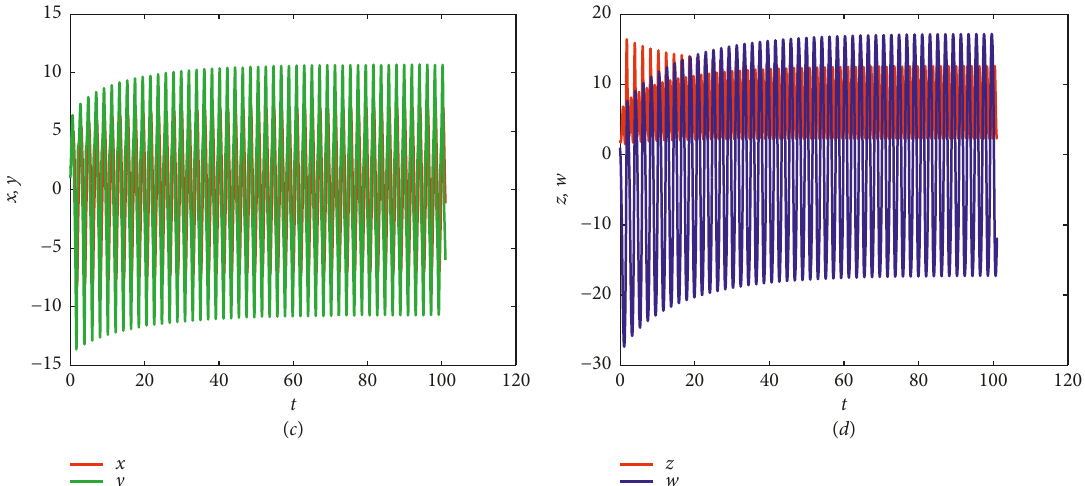
Figure 4: Time evolutions of Experiment 1 with a � 3 , b � 5: ( c ) x,y states; ( d ), z,w states.